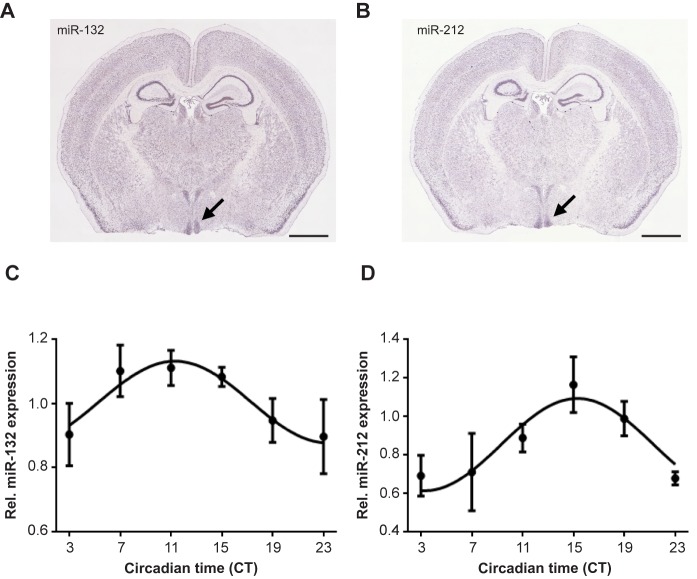
miR-132 and miR-212 expression in the SCN.(A, B) Gene expression patterns of miR-132 (A) and miR-212 (B) in the brain of 129/Sv mice measured by ISH. SCNs are indicated by arrows. (C, D) Relative gene expression profiles in constant darkness of miR-132 (C) and miR-212 (D) in the SCN of 129/Sv mice measured by dig-labelled ISH. Significant rhythms are illustrated with fitted cosine curves (Cosine-wave regression, F-test: (C) miR-132: p < 0.01, (D) miR-212: p < 0.05). Scale bar in A and B: 2 mm.